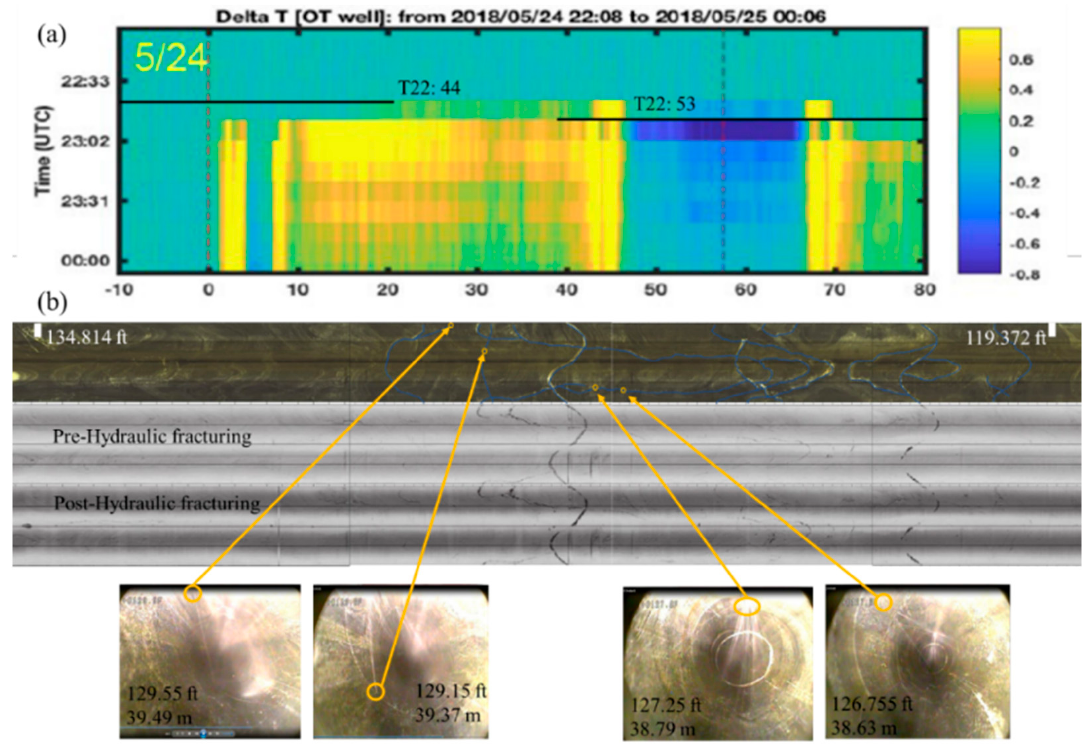
Figure 7. Observations at E1-OT and E1-P caused by injection [2]. ( a ) The temperature perturbations along E1-OT on 24 May. ( b ) The water jet occurs in E1-P at 126 ft and 129 ft depth. The water jetting was detected on 25 May.